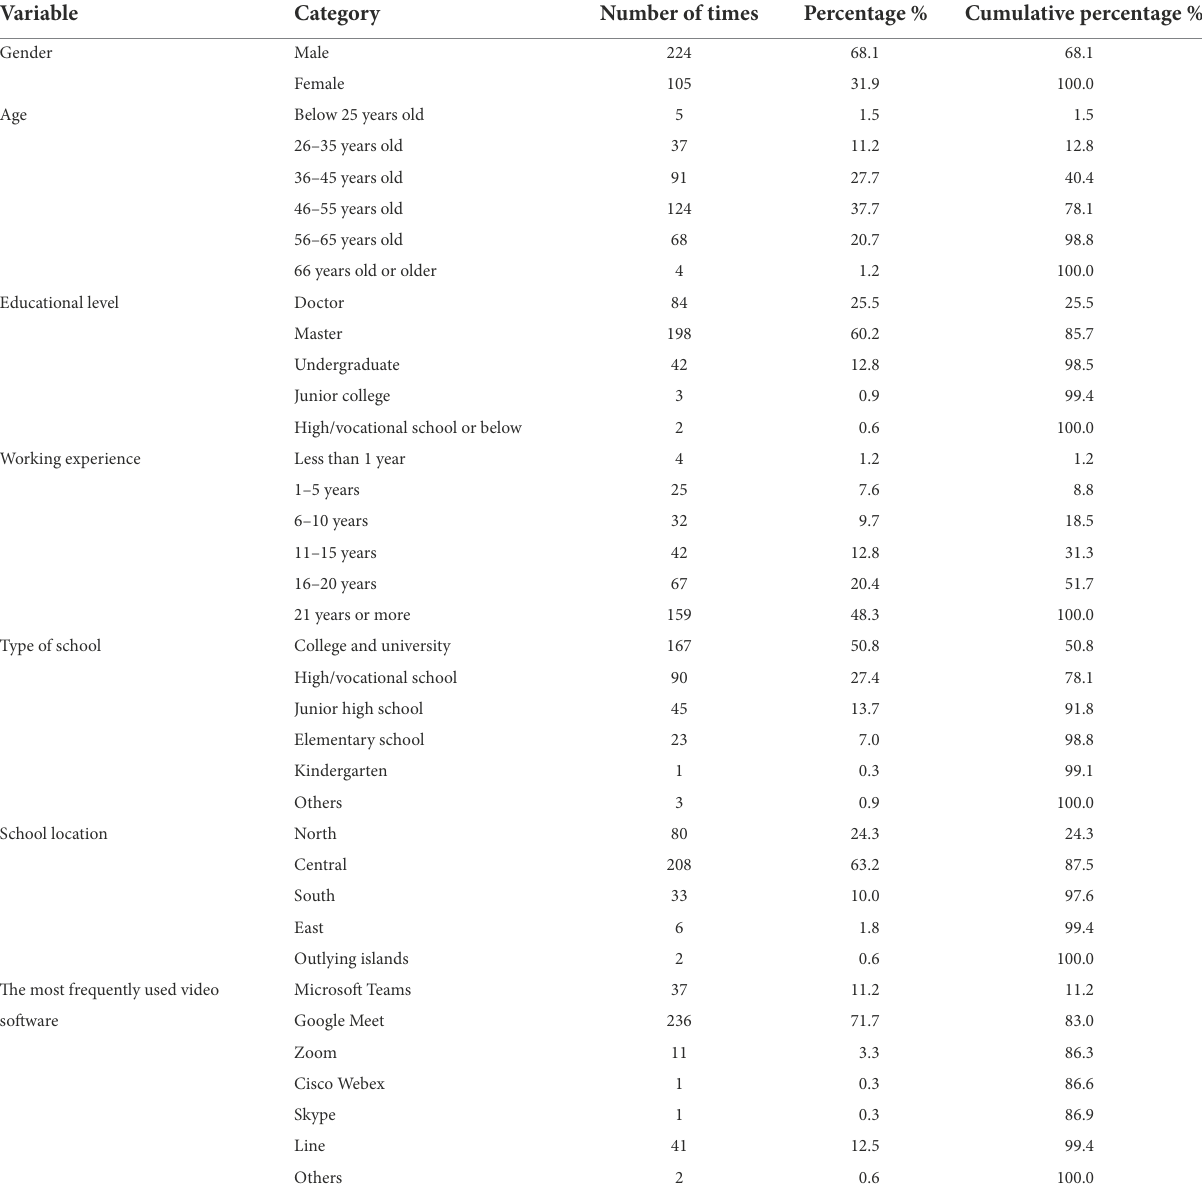
TABLE 1 Subjects’